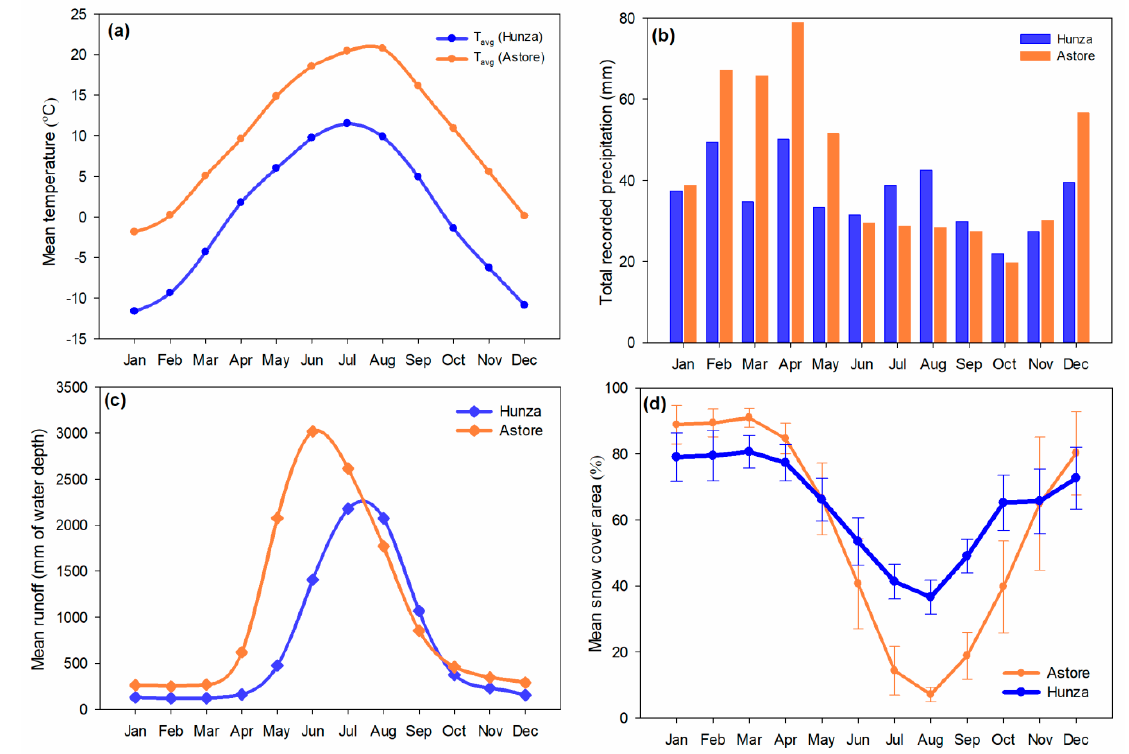
Figure 3. Hydro-climatic data representation in the Astore and Hunza basins ( a ) Mean monthly temperature variation (average of 2000–2013), ( b ) Total monthly precipitation (average of 2000–2013 totals), ( c ) Mean monthly runoff (average of 2000–2013), and ( d ) Basin-wide mean monthly snow cover area (with standard deviation bars) over a period of 2000 ‒ 2016.